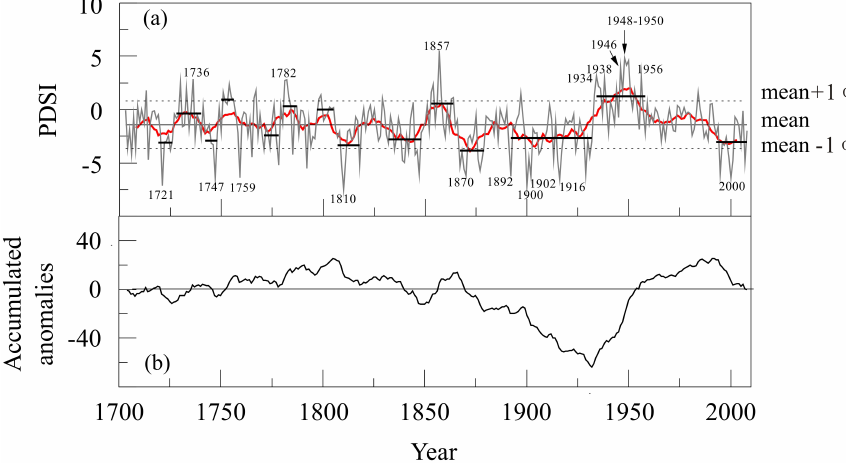
Fig. 6. (a) March–August PDSI reconstruction from 1703 to 2008AD. The thick red line is the 11yr moving average, the long horizontal line is the mean PDSI value of 1703–2008AD, and the short horizontal lines are the mean PDSI values for different dry/wet periods; (b) accumulated anomalies (AC) of the PDSI